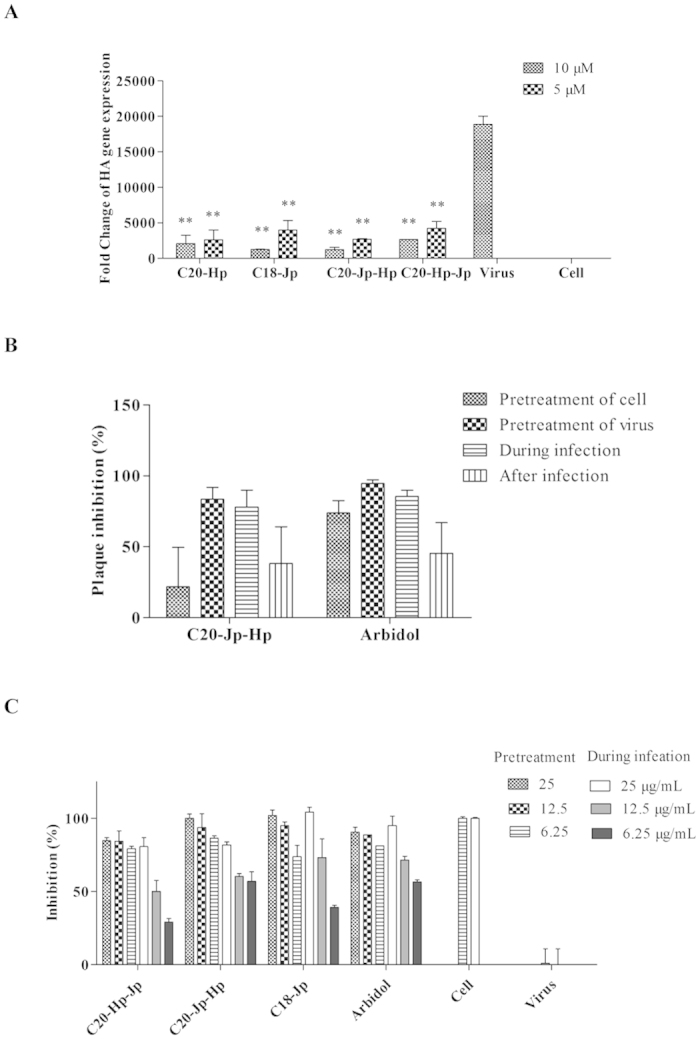
(A) The antiviral activity of selected peptides against influenza A/Puerto Rico/8/34(H1N1) by qRT-PCR. The peptides were pre-treated with A/Puerto Rico/8/34 virus at 100 TCID50 for 30 min, and then the virus-peptides mixture was transferred to the cells for another 1 h. At 24 h post-infection, the matrix gene was detected by quantitative real-time PCR. Statistical significance of the data with the virus group was defined as p  <  0.05 (*p  <  0.01, **p  <  0.001). (B) The plaque reduction assay of C20-Jp-Hp against influenza A/Puerto Rico/8/34(H1N1). The cells were divided into four groups. Group 1 (Pretreatment of cell): peptides were added to cell monolayers for 30 min before influenza virus adsorption at 37 °C under 5% CO2. Group 2 (Pretreatment of virus): peptides were pre-incubated with influenza virus for 30 min at 37 °C before added into the cells. Group 3 (During infection): virus A/PR/8/34 (100 TCID50) with peptide (10 μM) was simultaneously added to cells. Group 4 (After infection): peptides were added to cell monolayers after influenza virus adsorption at 37 °C under 5% CO2 for 30 min. After incubation at 37 °C 5% CO2 for 48 h, the plaques from each group were counted. Arbidol (5 μM) was used as positive control. (C) In vitro time-of-addition studies on anti-influenza viral activity of the C20-Jp-Hp and C20-Hp-Jp by CPE reduction assay in MDCK cells. Arbidol was used as positive control. Each data was performed in triplicate, and three independent determinations were carried out.